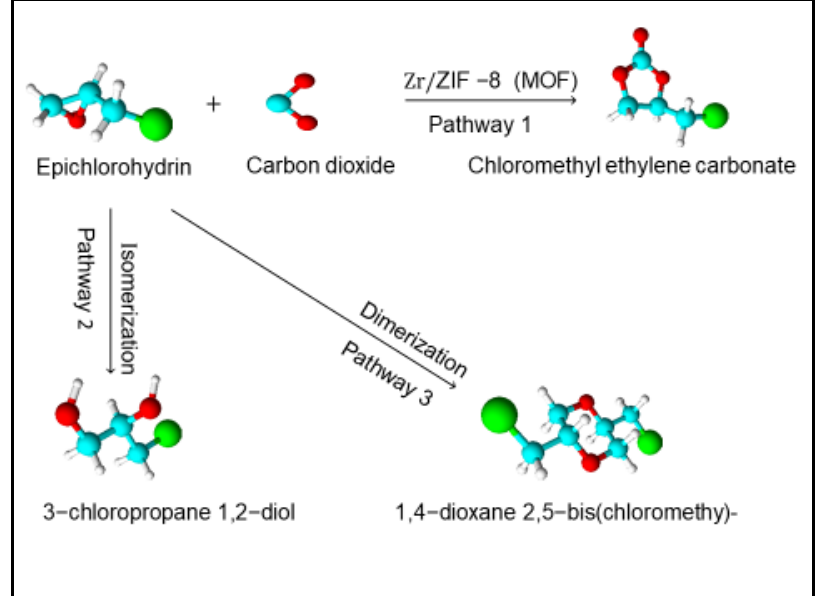
Figure 1. Reaction pathways for cycloaddition reaction of epichlorohydrin (ECH) and carbon dioxide (CO 2 ).